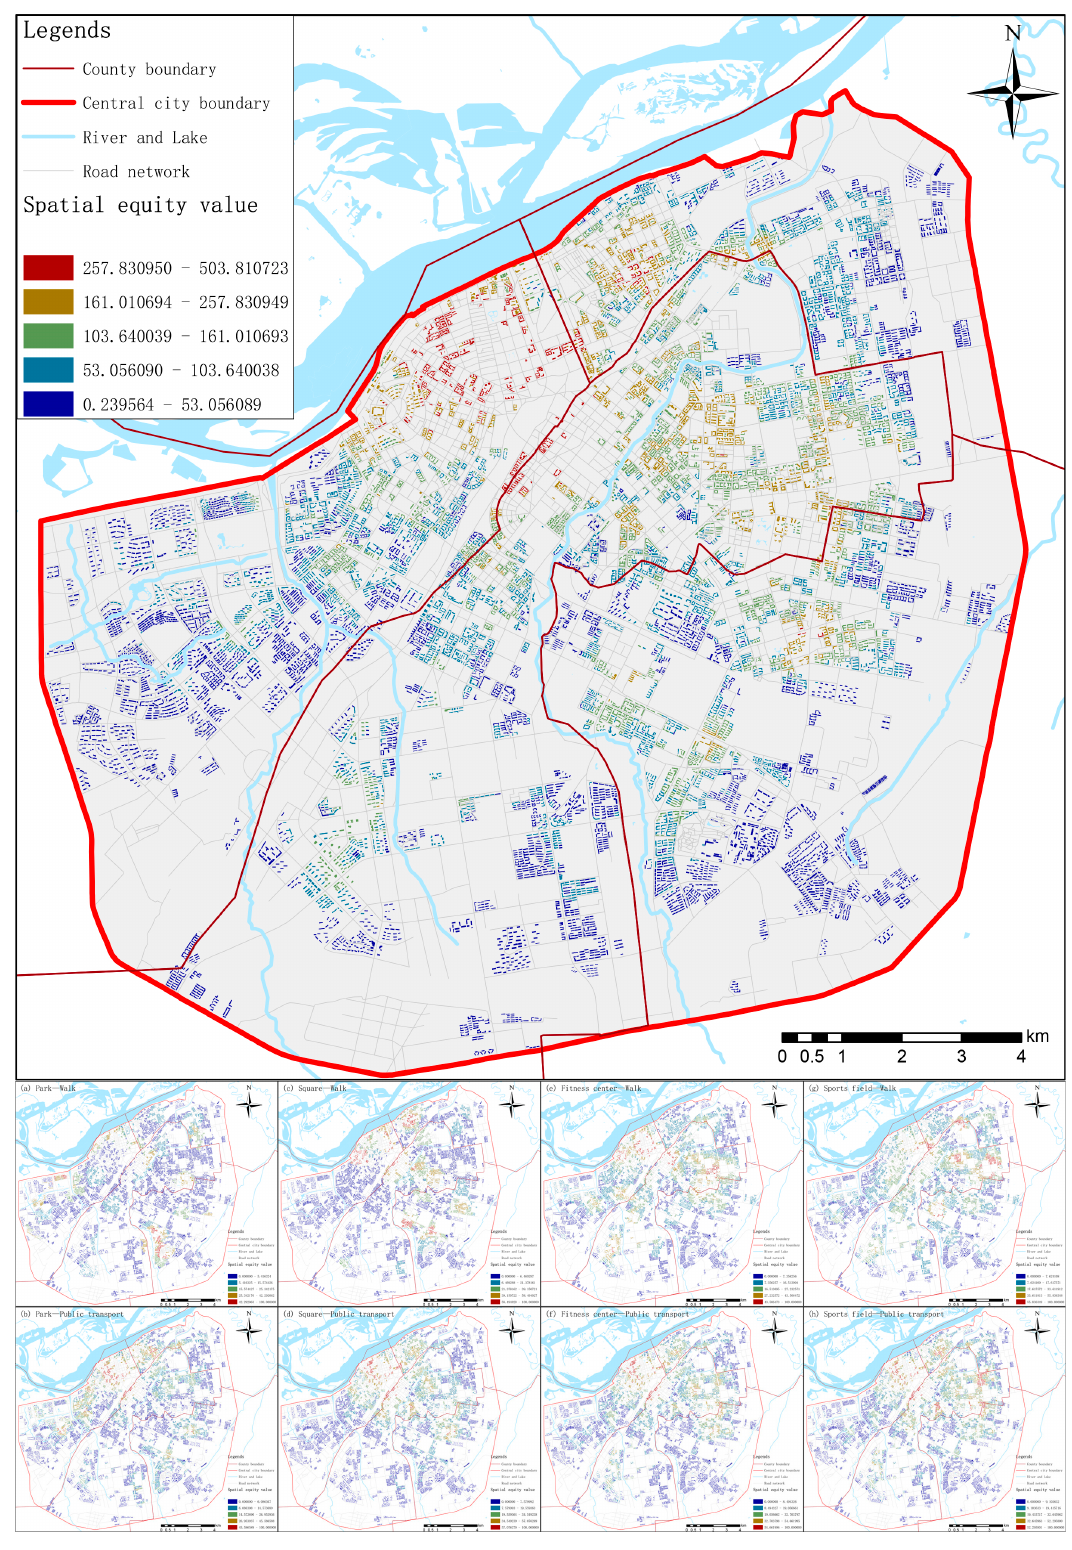
Figure 3. Equity distribution map of sports space in central urban